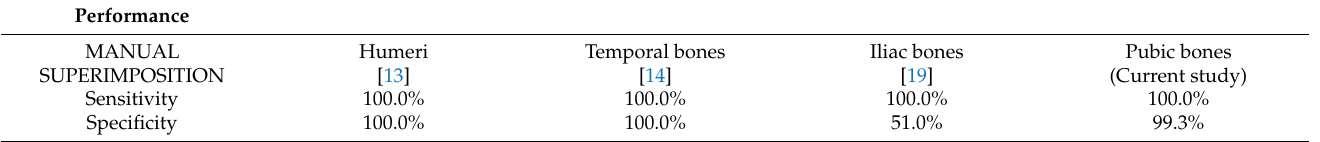
Table 3. Summary of the sorting performance of digital manual pair-matching across published